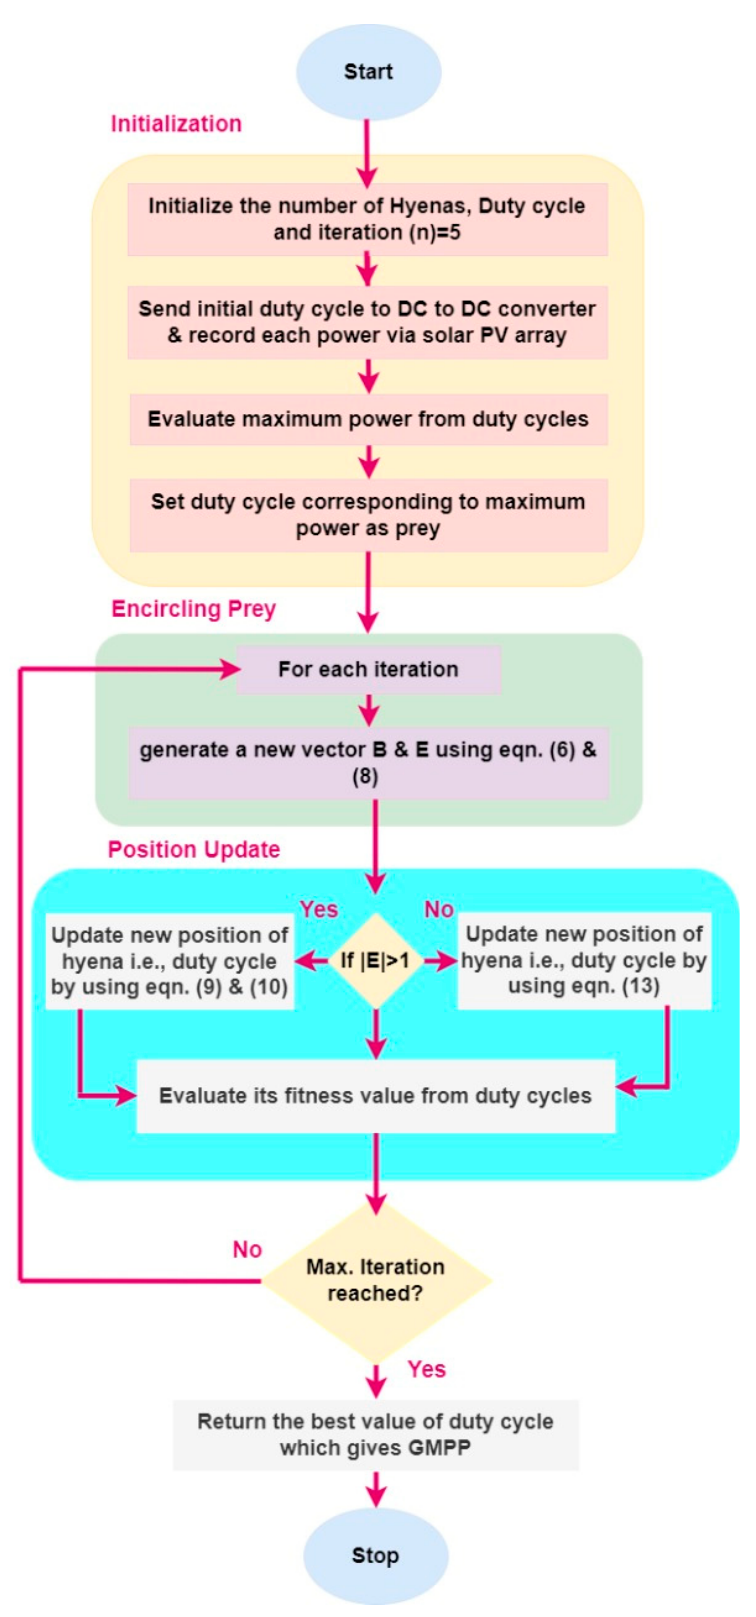
Figure 7. Flow chart for SHO.